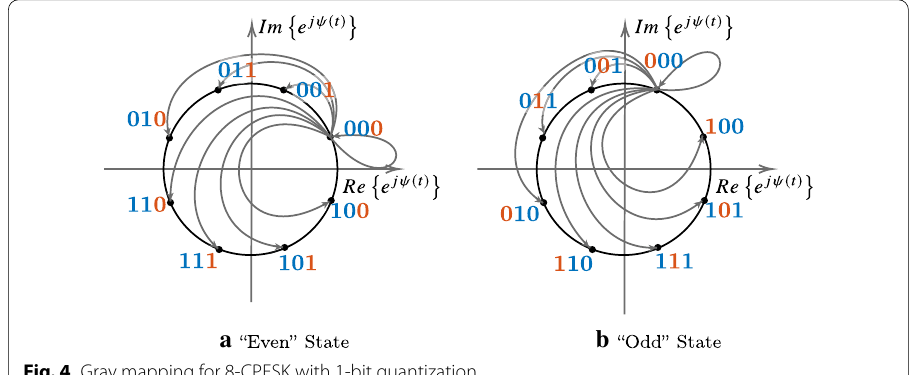
Fig. 4 Gray mapping for 8-CPFSK with 1-bit